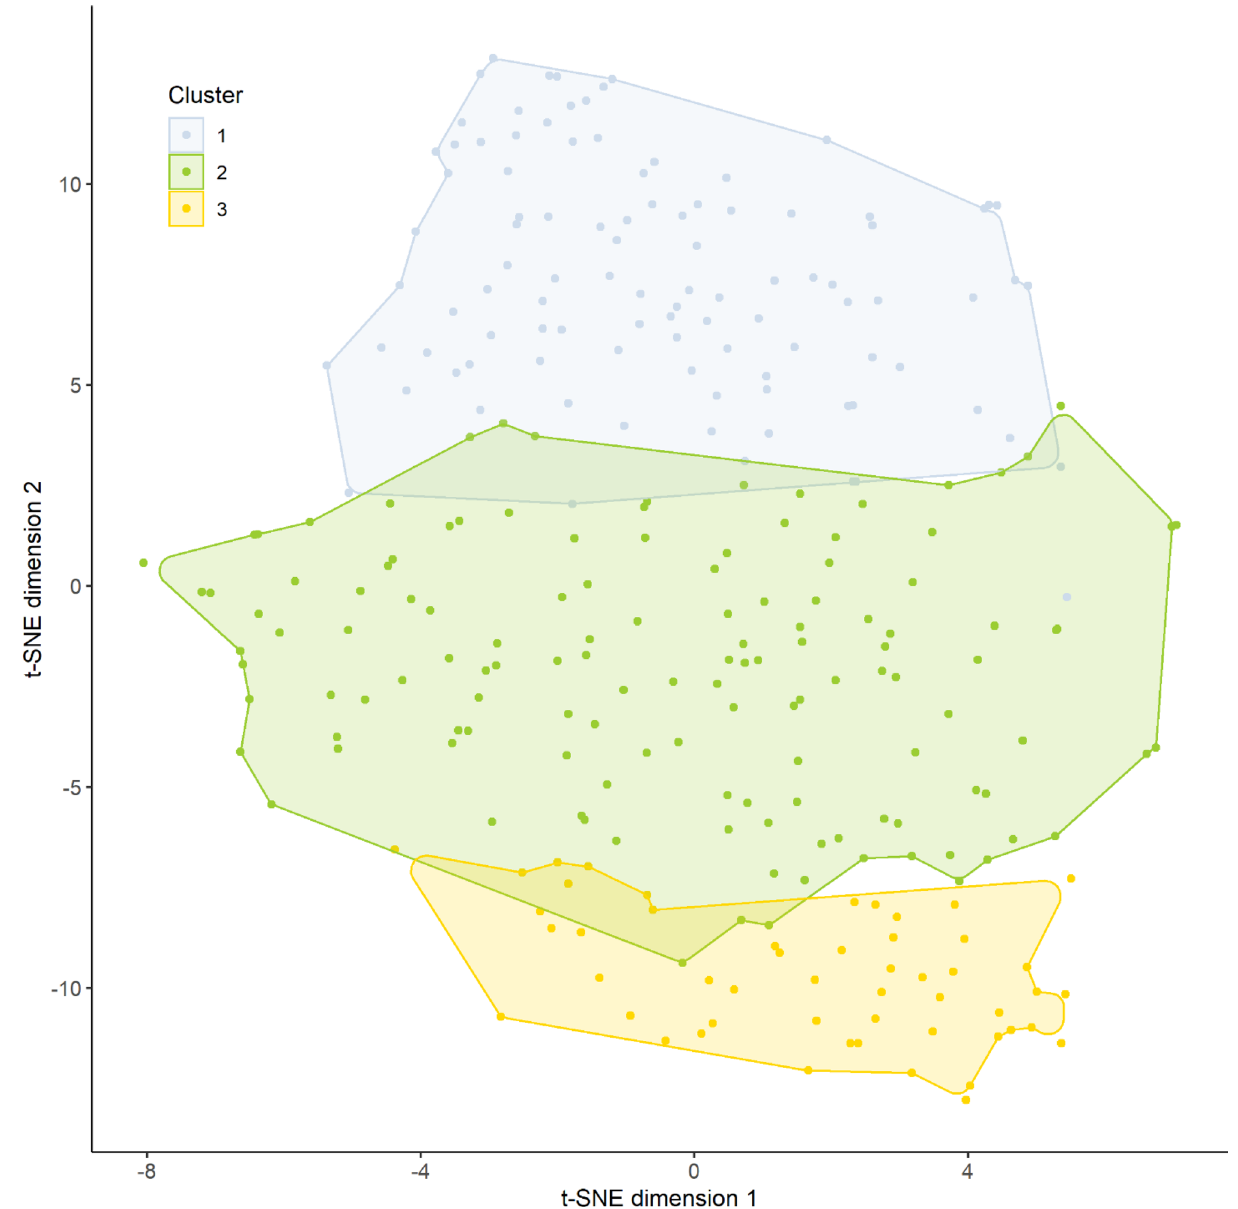
Figure 1. Comparison between t-SNE clustering and k-medoids clustering with three temperature time series clusters. Shaded area represents the convex hull of observations within a specific cluster. Figure produced using R Core Team (2021). R: A language and environment for statistical computing. R Foundation for Statistical Computing, Vienna, Austria. https:// www.R- proje ct.